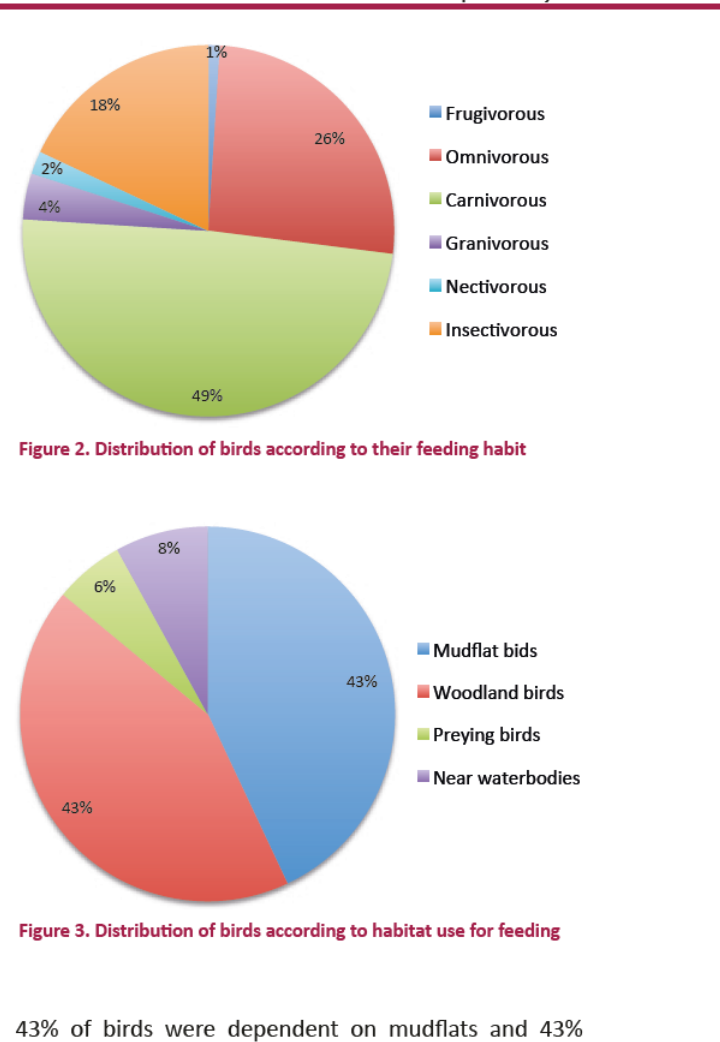
Ffigure 3. Dfistrfibufion off bfirds accordfing to habfitat use ffor ffeedfing